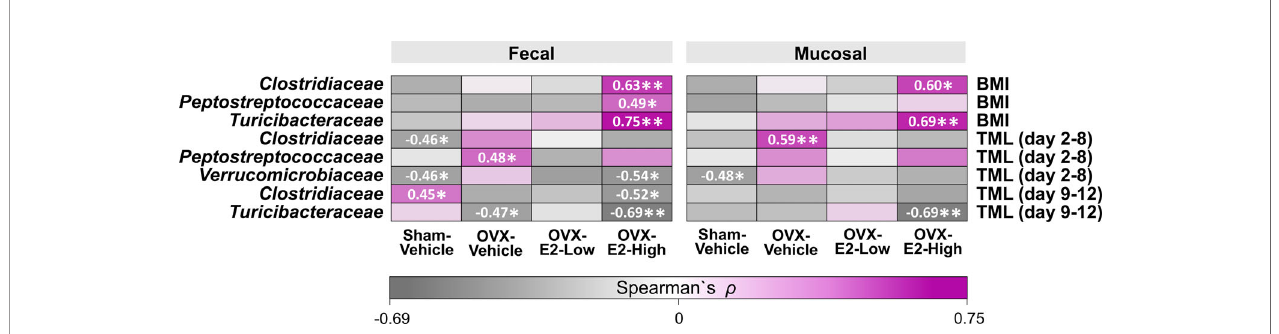
FIGURE 6 | Heatmap of positive and negative correlations for each Treatment group between intestinal microbial families and Body mass index (BMI) at the end of experiment as well as cognitive data (Total Maximum Load [TML]) during Learning and Asymptotic Phases of the WRAM. The asterisks indicate signi fi cant differences (*p ≤ 0.05; **p ≤ 0.01) whereas the shades and numbers indicate the degree of correlation. Group abbreviations (e.g., Sham-Vehicle) are described in Table 1